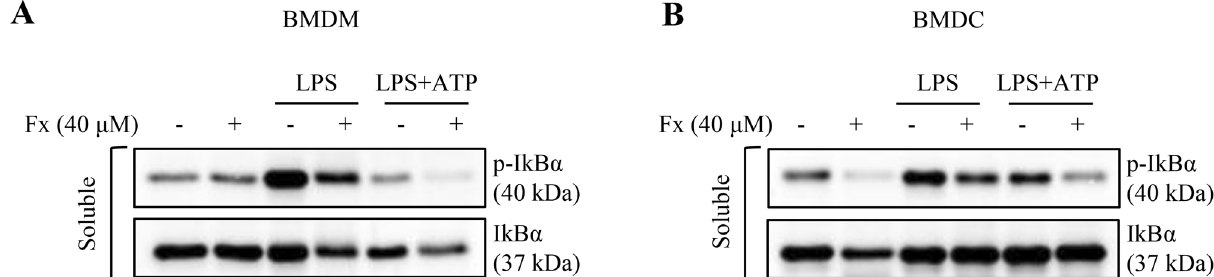
Figure 5. Regulation of NF-κB signaling by fucoxanthin. ( A , B ) Cellular expression levels of phosphorylated IκBα expression in bone marrow-derived macrophages (BMDMs) ( A ) and dendritic cells (BMDCs) ( B ) treated with LPS alone or a combination of LPS and ATP with or without fucoxanthin.